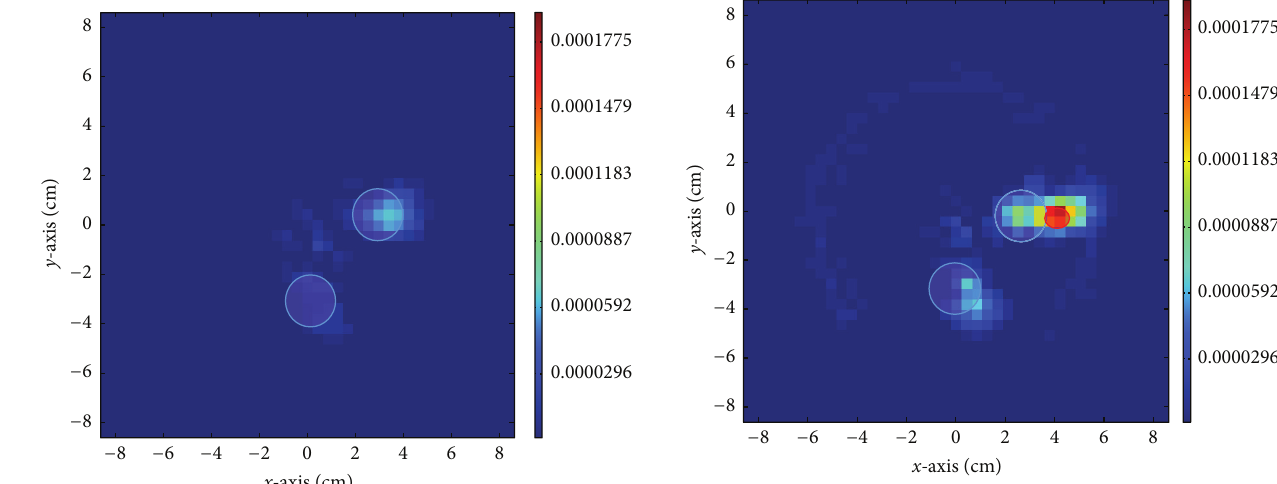
Figure 8: Reconstructed image from the multistatic dataset recorded from the experimental setup shown in Figure 7. The green circles denote the location of the dense tissue structures.